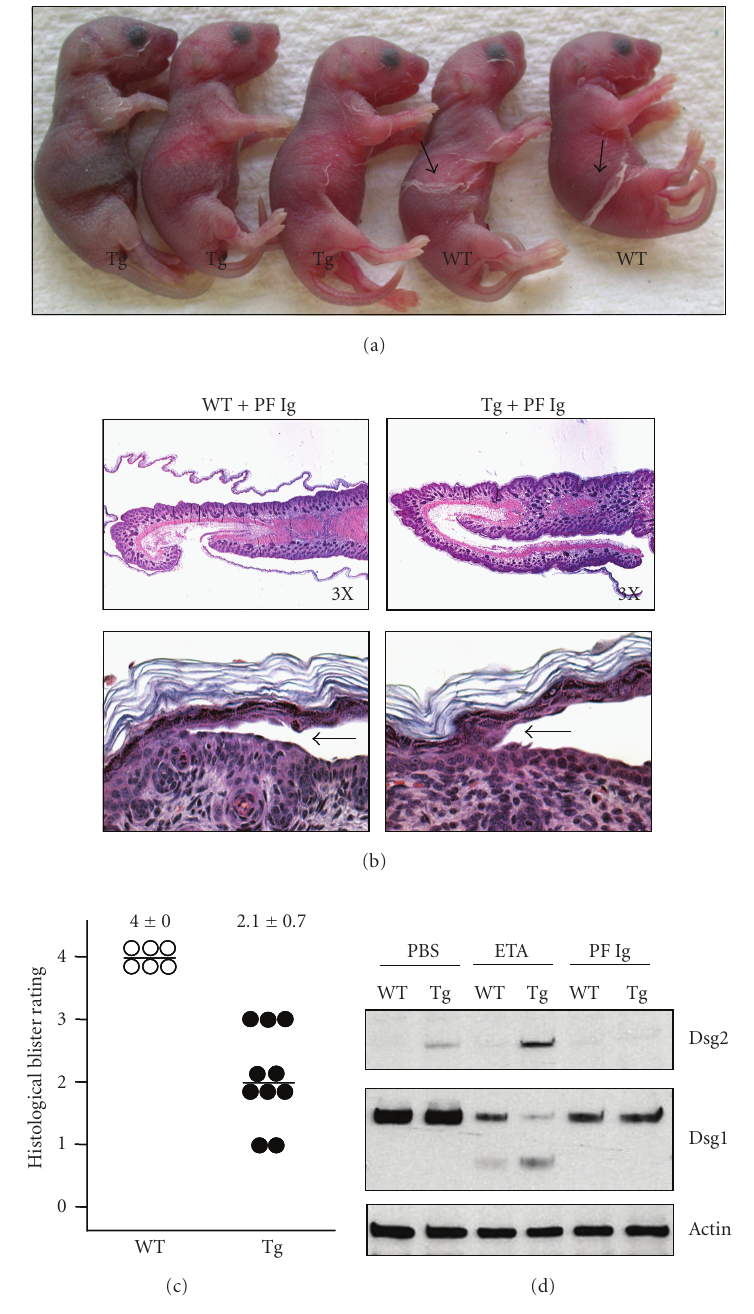
Figure 4: Dsg2 o ff ers protection against PF Ig-induced acantholysis. (a) Newborn WT and Inv-Dsg2 Tg mice were injected subcutaneously with 10mg of purified PF Ig for 18 hours. Gross blisters were more pronounced in WT mice, as compared to Tg mice. (b) Mice were sacrificed, and their skin was processed for histology, revealing more dramatic blisters in the WT ( n = 6) than in Tg mice ( n = 10). Top panels show 3X magnification, and lower panels show 40X magnification of the site of blister formation (arrows). (c) The extent of blistering was graded as described in Figure 2. Each dot represents one animal. The average blister scores were 4.0 ± 0.0 for WT mice and 2.1 ± 0.7 for Tg mice. These values were statistically significant, P ≤ .000022 (2-tailed unequal variance) or ≤ .000012 (1-tailed unequal variance). (d) Back skin biopsies of WT and Tg mice treated with PF Ig were homogenized in Laemmli bu ff er, the proteins were resolved with SDS-PAGE and immunoblotted for Dsg1 (27B2), Dsg2, and Actin. Western blotting demonstrates that superficial Dsg2 slightly enhances retention of Dsg1 in response to PF